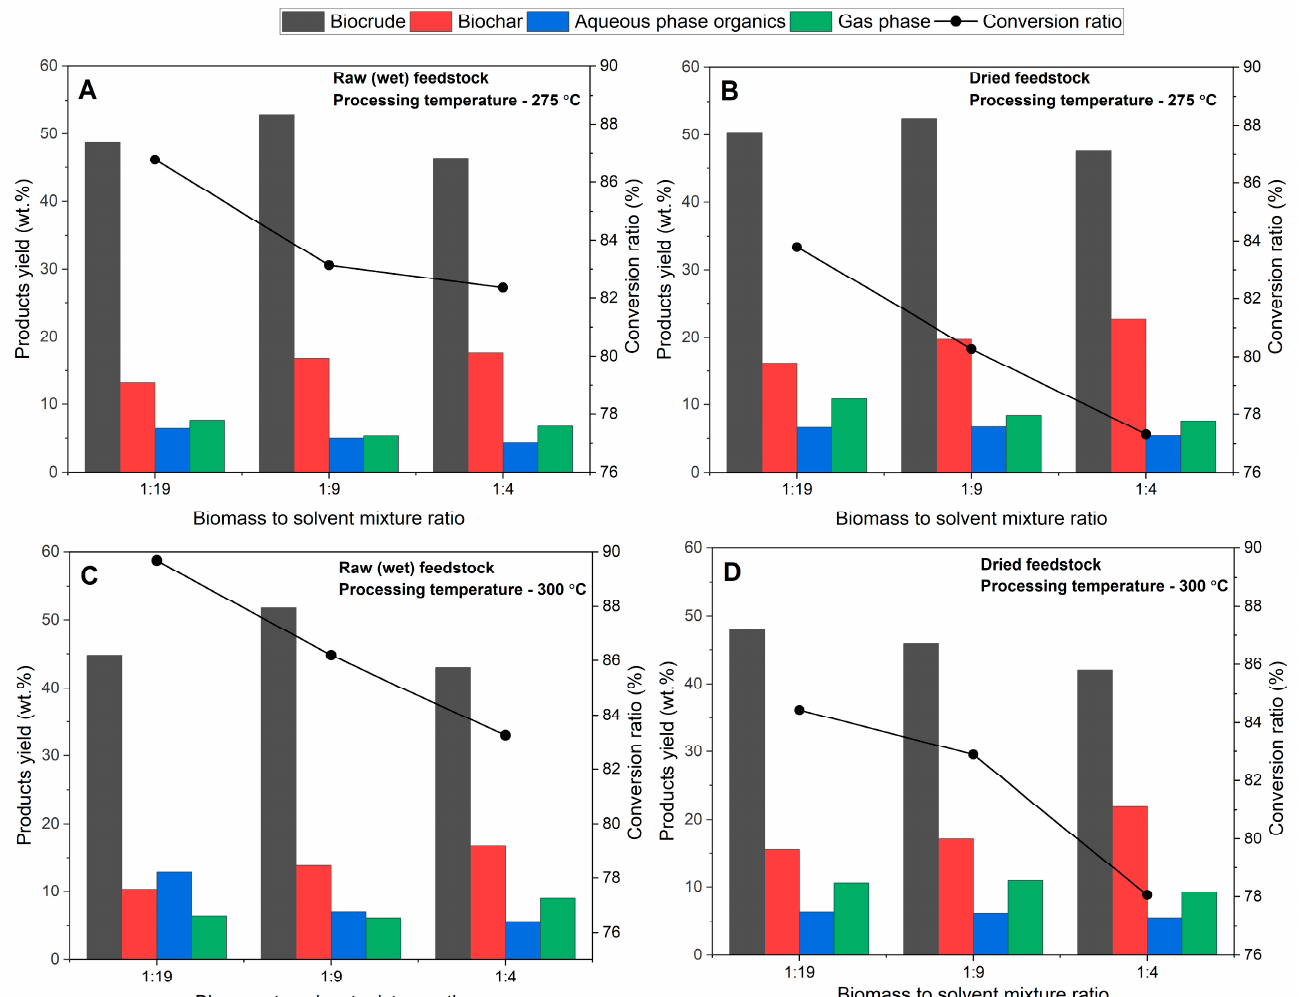
Figure 2. Effect of biomass-to-solvent ratio on yield distribution of bioproducts for tests carried out at different conditions: T = 275 °C, wet ( A ) and pre-dried ( B ) feedstock; T = 300 °C, wet ( C ) and pre- dried ( D ) feedstock.